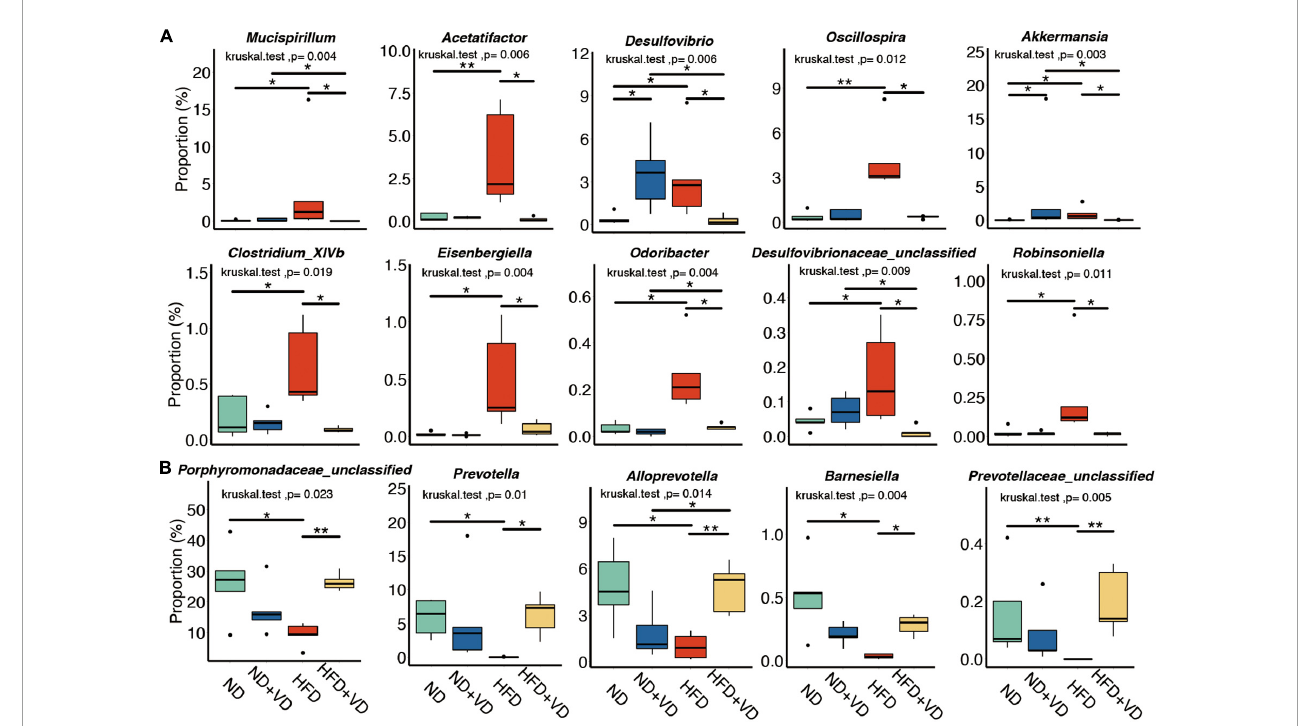
FIGURE3 Identification of specific altered bacteria for vitamin D (VD) intervention. (A,B) Significantly changed gut microbiome in four groups. * P < 0.05, ** P < 0.01. Kruskal–Wallis test with post-hoc Dunn’s test.